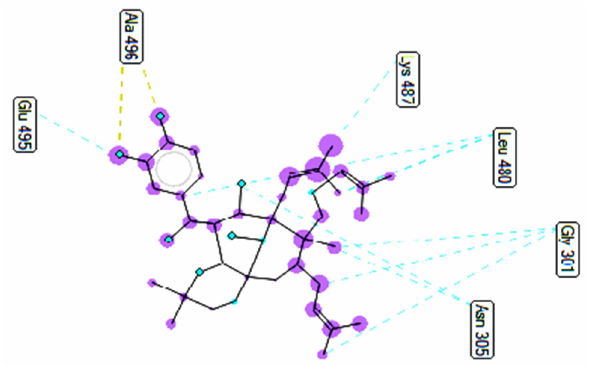
Figure 17. The significant ligand interactions between pose 158 and active residual amino acids on enzyme 2VF5 indicated in one 2D diagram.